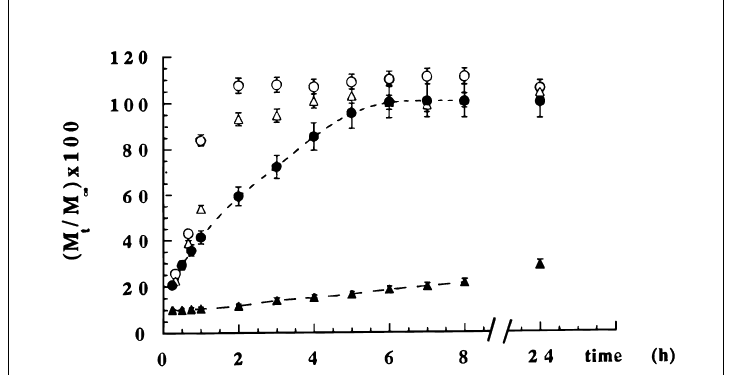
Release profiles of TPH in phosphate buffer (pH=7.4) at 37 °C from tablets prepared with the CCP polymer and with a gellan/Scgl weight ratio equal to 85/15. Experiments were carried out in the absence and in the, presence of Ca +2 . CCP, r =0 ( ● ); CCP, r =3 ( ▲ ); gellan/Sclg 85/15, r =0 ( ○ ); gellan/Sclg 85/15, r =3 ( ∆